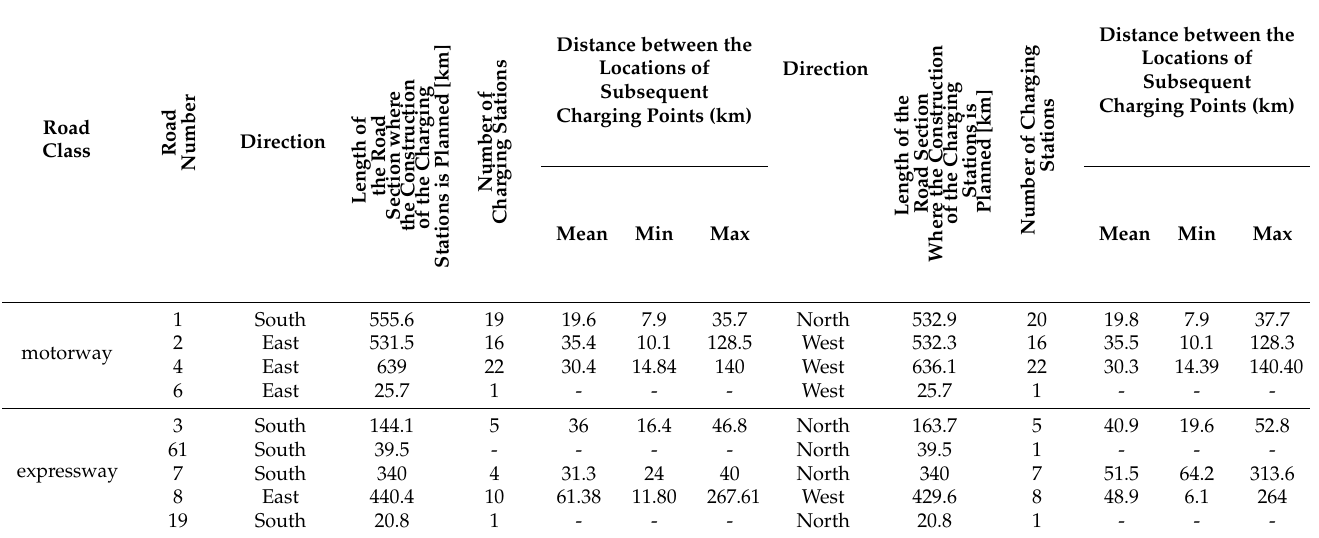
Table 4. Planned number of charging stations along the TEN-T network in Poland.